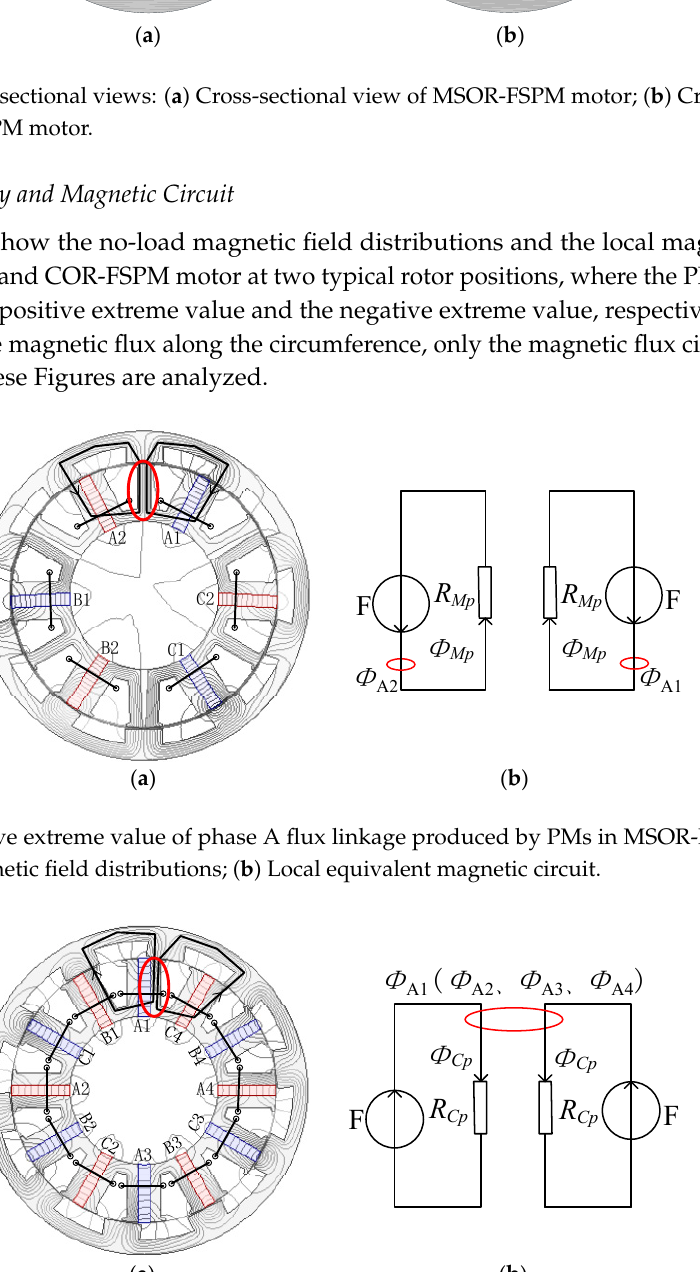
Figure 15. Positive extreme value of phase A flux linkage produced by PMs in COR-FSPM motor: ( a ) No-load magnetic field distributions; ( b ) Local equivalent magnetic circuit.